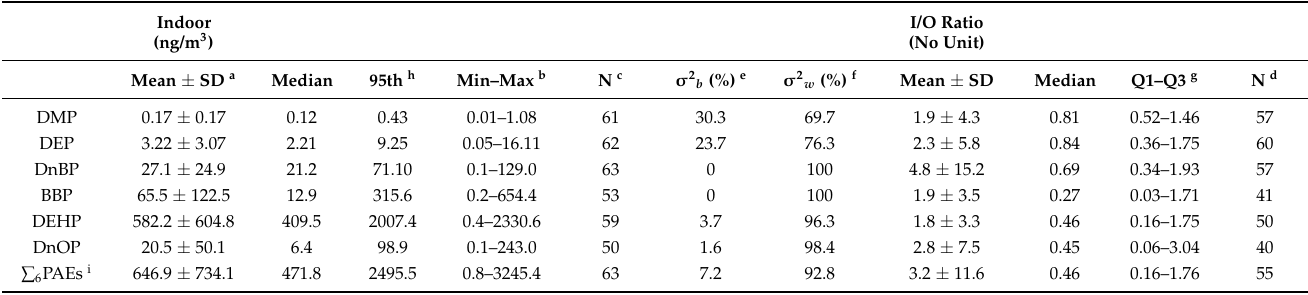
Table 3. Summary statistics of PAE congeners and ∑ 6 PAEs in residential indoor PM 2.5